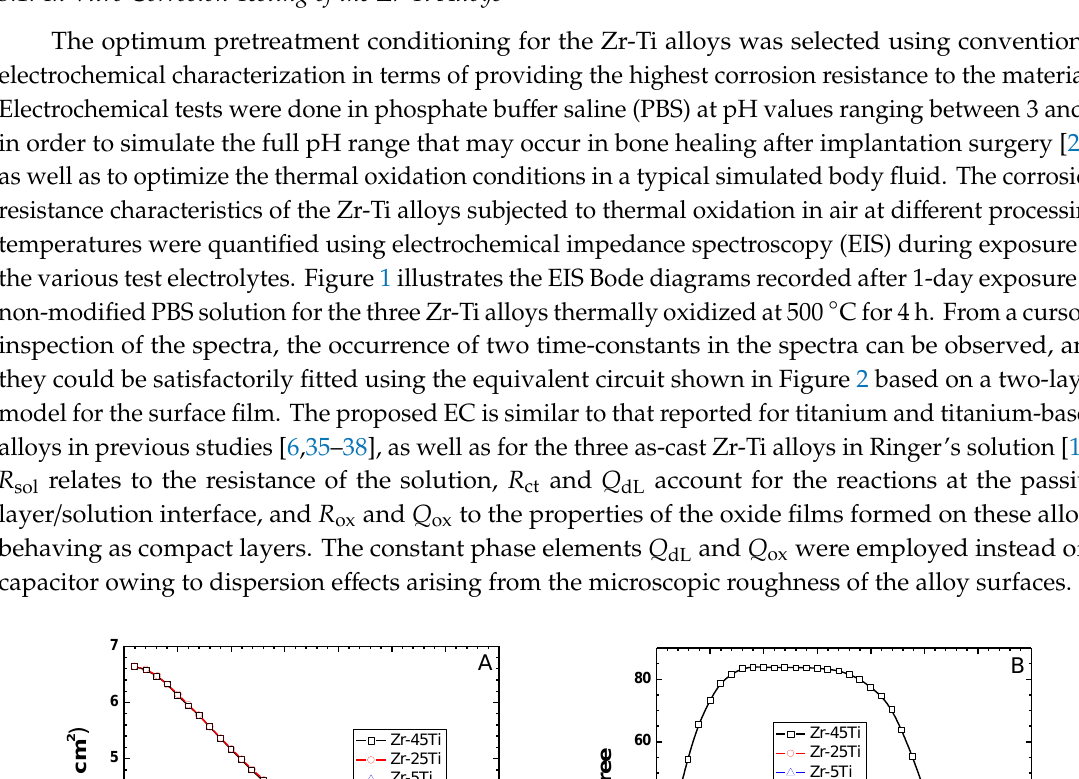
Figure 2. Equivalent electric circuit employed to fit the experimental EIS spectra.